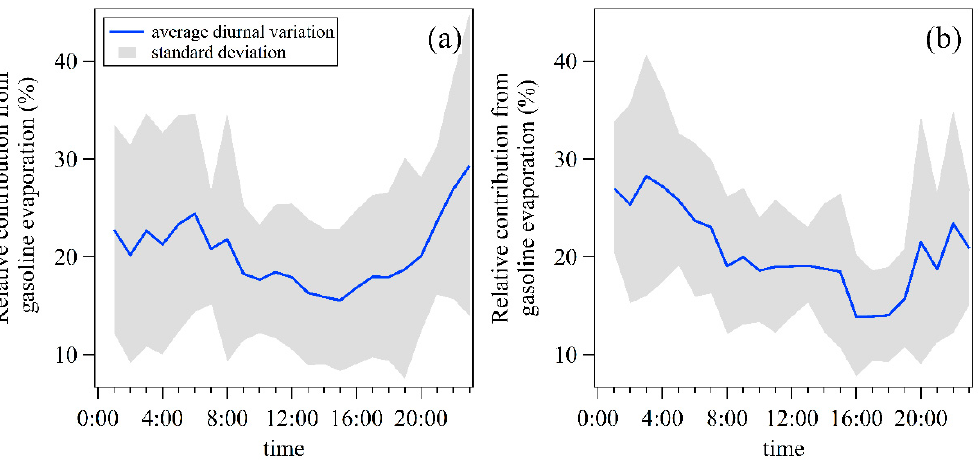
Figure 10. Average diurnal variation patterns of relative contributions from gasoline evaporation to NMHCs mass con-